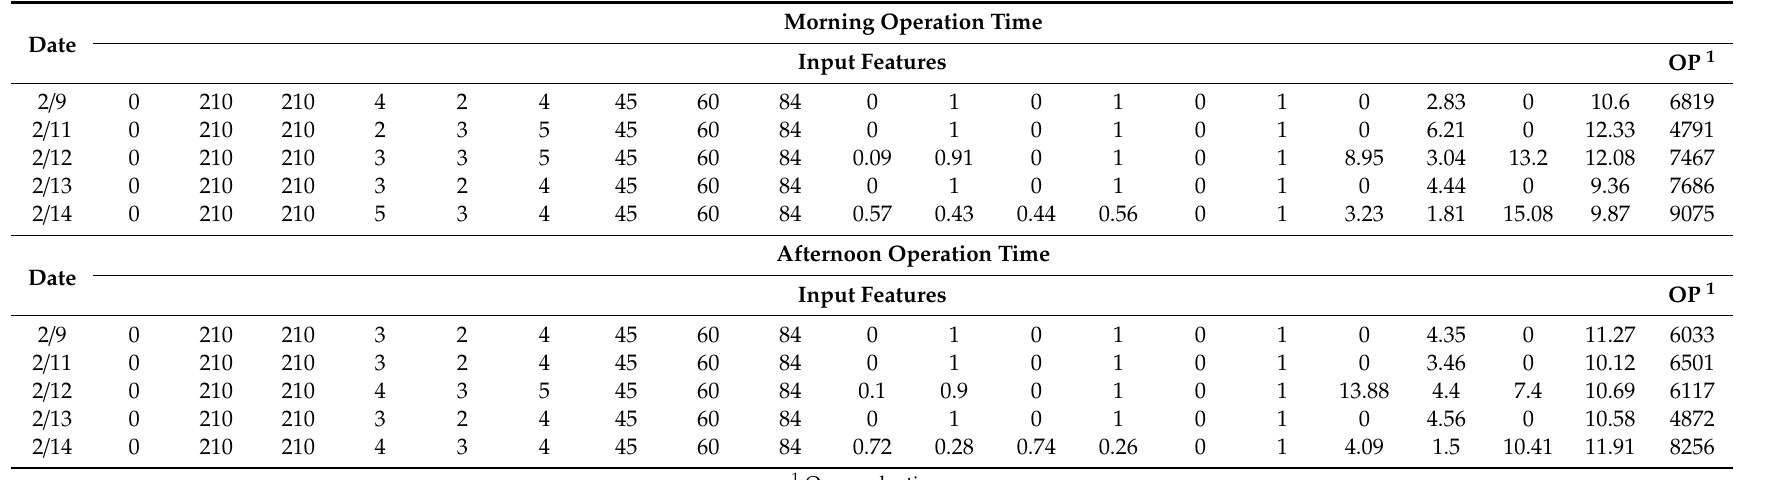
Table 5. Data provided as input to DNN models for predicting ore production during morning and afternoon operation